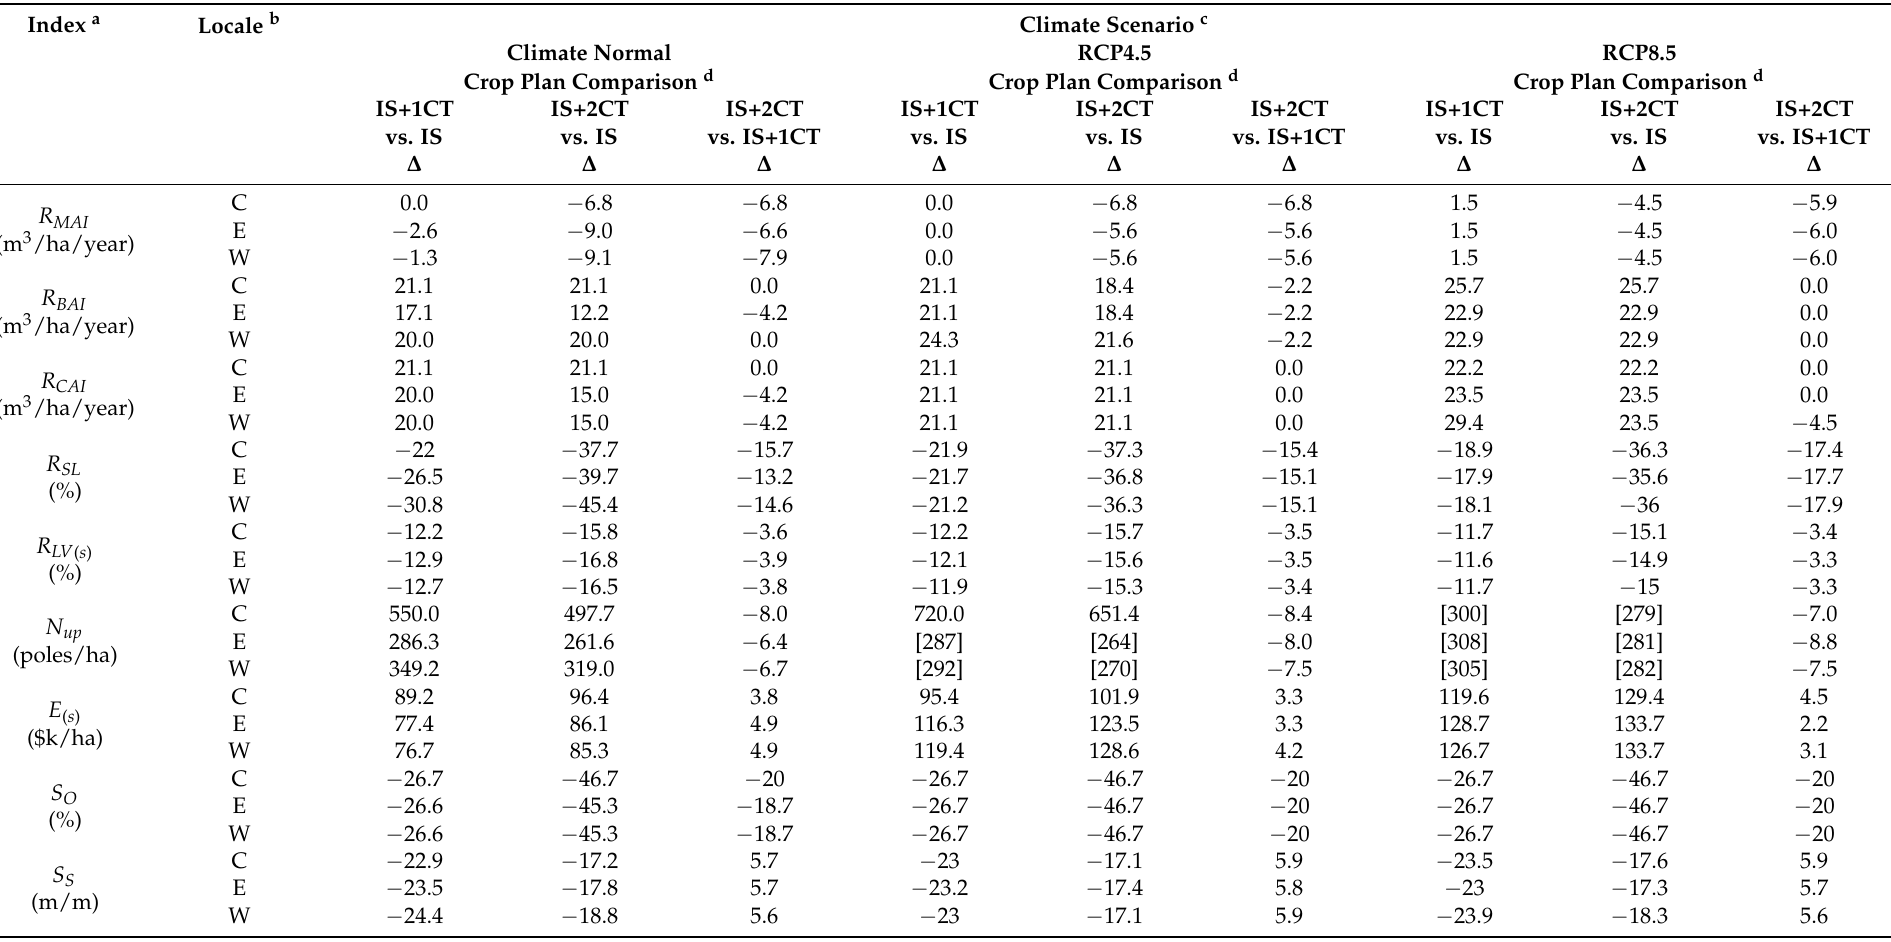
Table 6. Climate-specific silvicultural effectiveness comparisons among the selected red pine crop plans for plantations situated in north-central (Thessalon), north-eastern (Kirkland Lake) and north-western (Thunder Bay) Ontario: SSDMM-derived rotational yield comparisons for three crop plans growing under three climate change